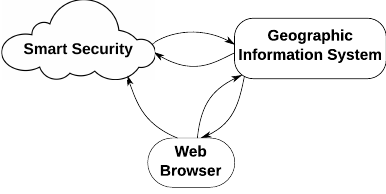
Figure 1. General architecture for a smart security in smart cities assisted by geovisualization.